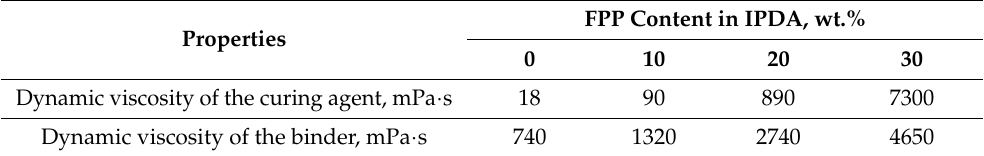
Table 3. Viscosity of the curing agent and the studied compositions vs. The modifier content.